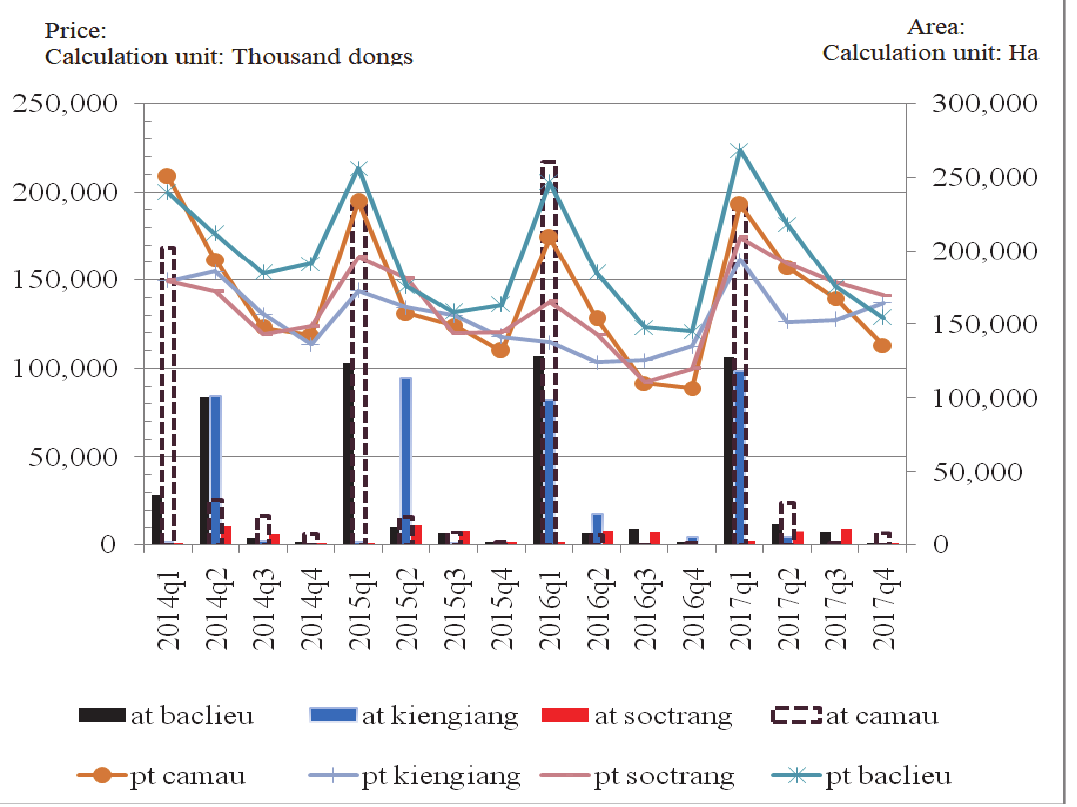
Fig. 1. Area and price of black tiger shrimp through time Source: General-Statistics-Office and MARD,